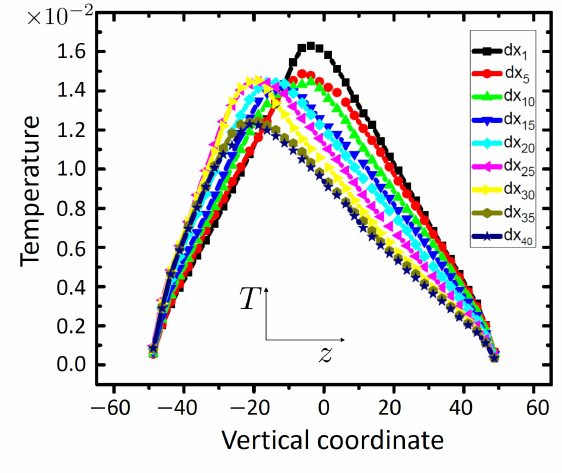
Figure 5. Temperature profiles ( T versus the vertical coordinate, z ) evaluated within thin parallel slabs of five particle diameter thickness. The curve legends give the integer index of the considered slab (e.g., dx 5 is the slab number 5 along the x -direction).